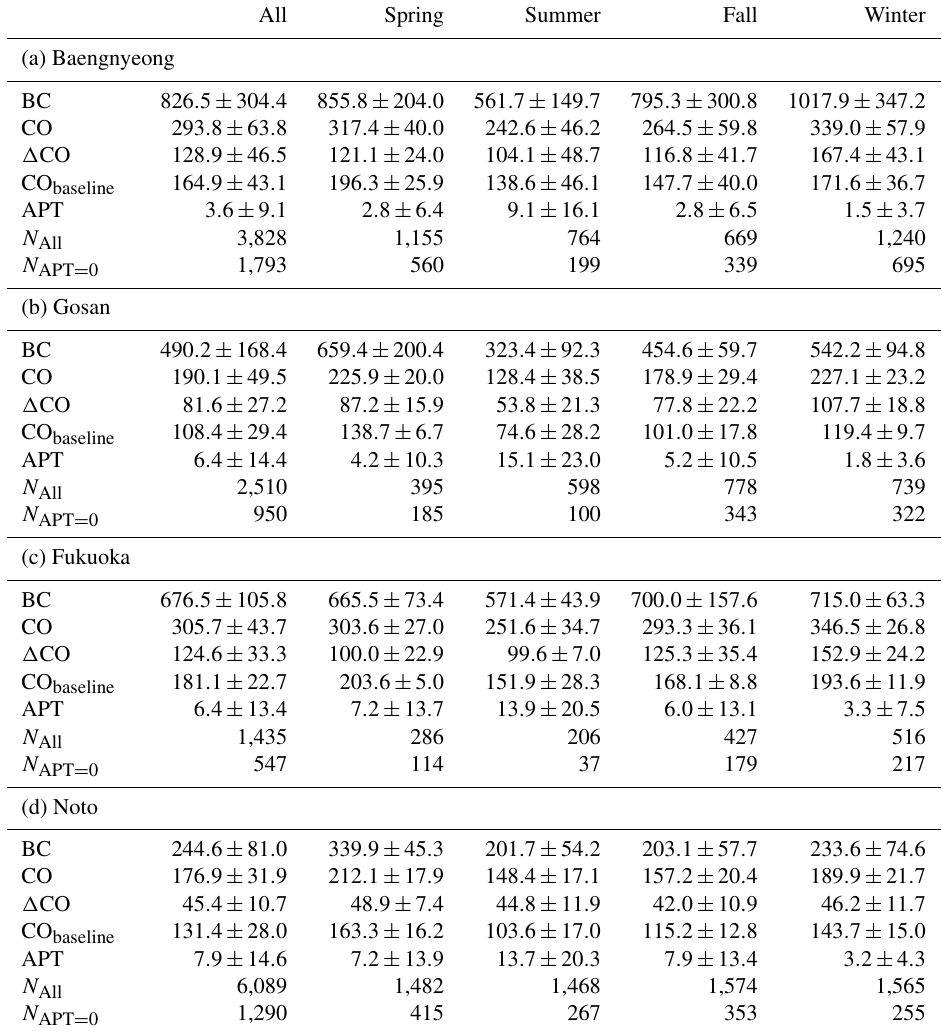
Table 2. Means and standard deviations of the black carbon (BC) a , carbon monoxide (CO) b , (cid:49) CO concentrations b , CO baseline b , amount of APT c , and the number of data for all ( N all ) and APT = 0 ( N APT = 0 ) cases at each site. All Spring